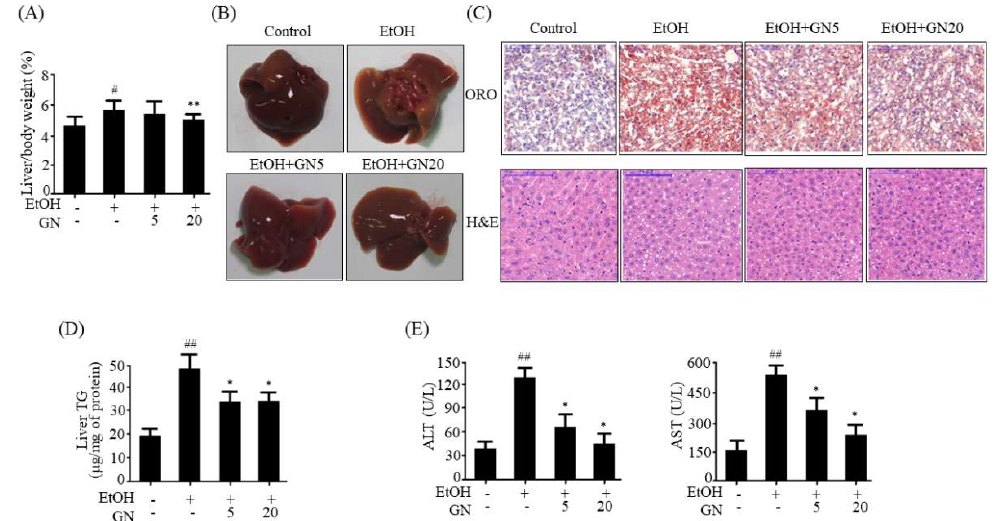
Figure 1. Gomisin N attenuates ethanol-induced hepatic steatosis in chronic-binge ethanol-fed mice. C57BL/6 mice were either pair-fed control or ethanol-containing diet with or without Gomisin N (GN) (5 or 20 mg/kg) for 10 days. ( A ) Ratios of liver-to-body weight, ( B ) Liver morphology. Representative images are shown. ( C ) oil red O (ORO) staining ( upper middle ) and hematoxylin and eosin (H&E) staining ( bottom ) (scale bar = 100 μm). Representative images are shown. ( D ) Hepatic levels of triglyceride (TG). ( E ) Serum levels of alanine aminotransferase (ALT) and aspartate transaminase (AST). Values are the mean ± SD ( n = 6). # p < 0.05, ## p < 0.01 vs. pair-fed control mice, * p < 0.05, ** p < 0.01 vs. ethanol-fed mice.